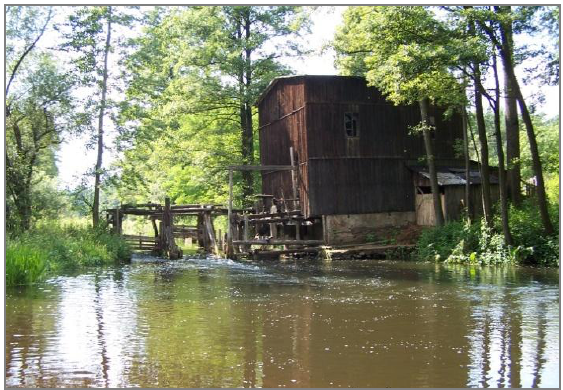
Fig. 5. Krym mill in the lower reach of the River Liswarta ( M. Fajer